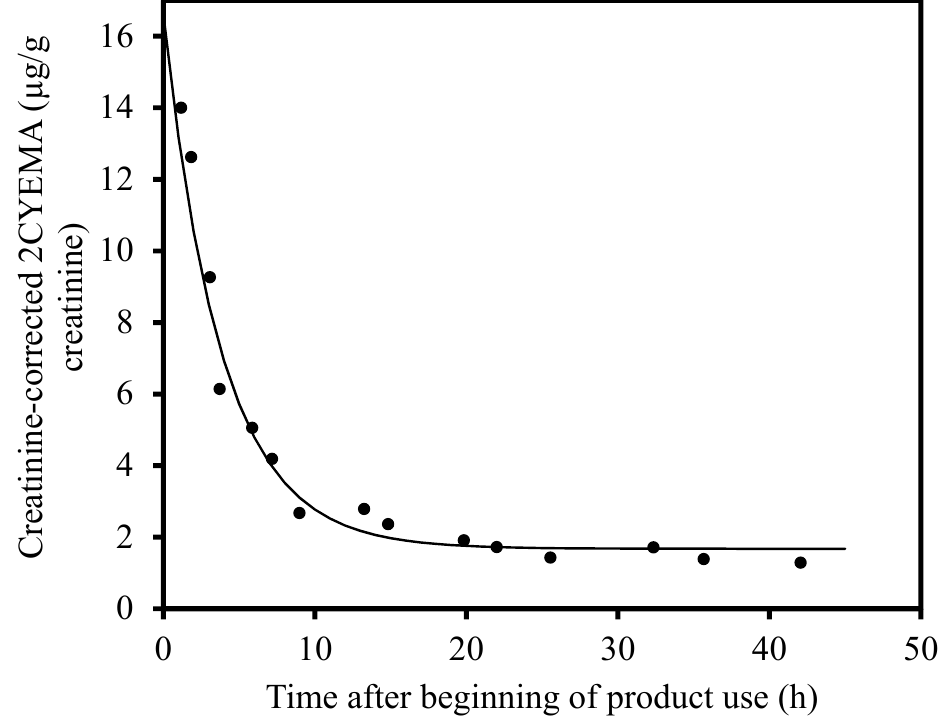
Figure 2. Post exposure creatinine-corrected urine 2CYEMA ( µ g / g creatinine) over time following smoking of a cannabis joint by an occasional cannabis user with a best-fit exponential